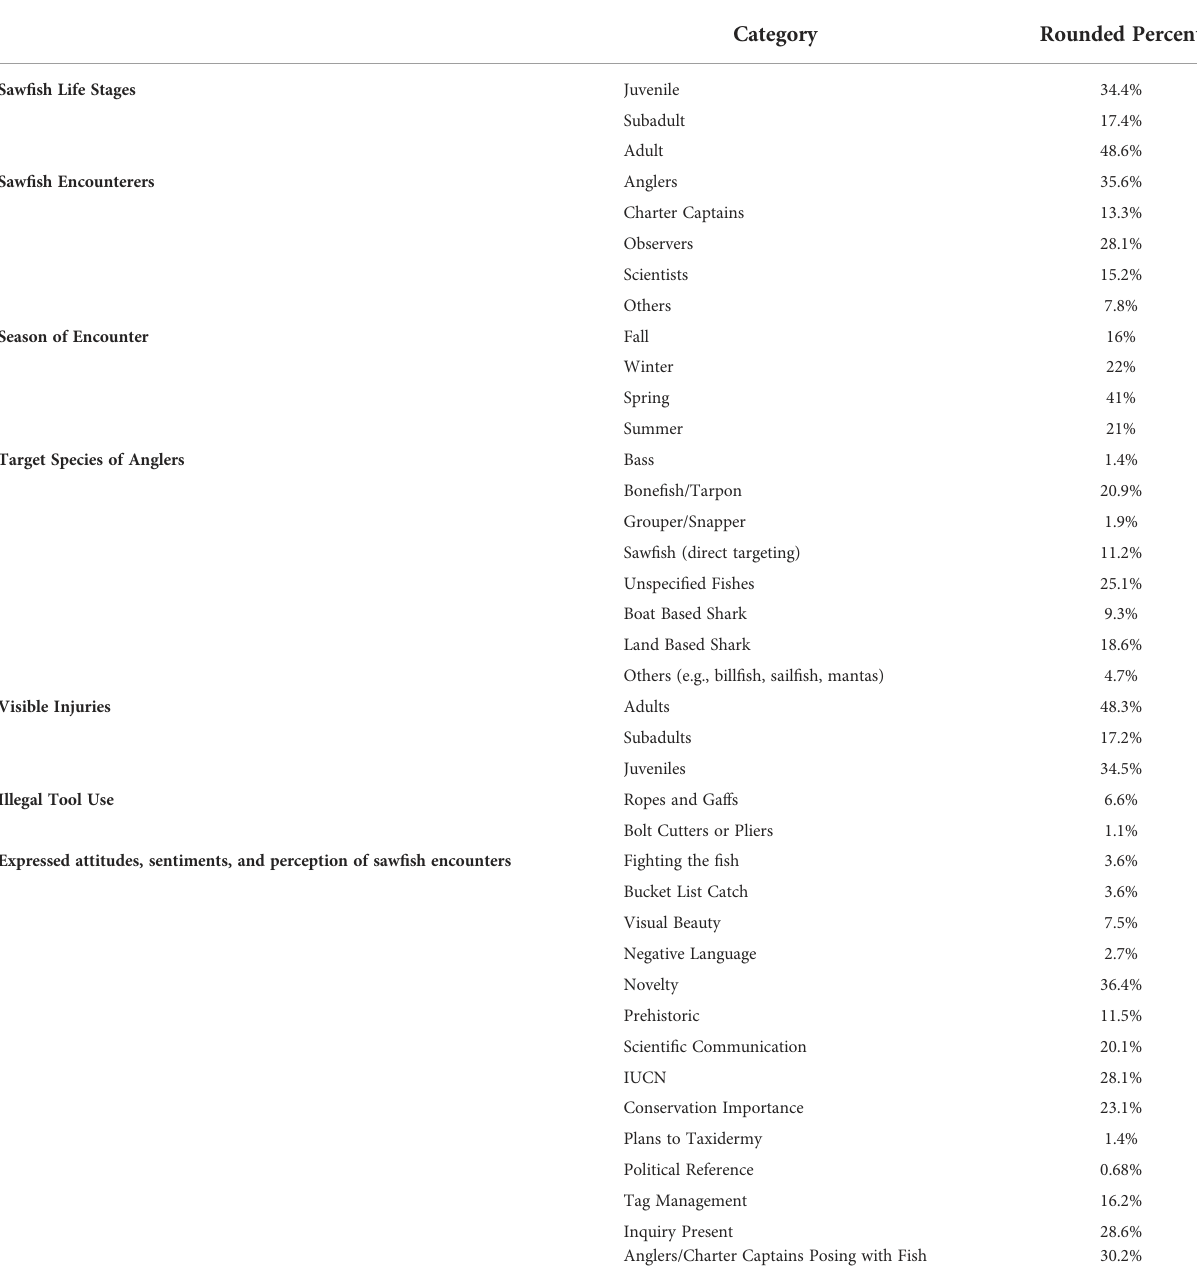
TABLE 2 Summary of all